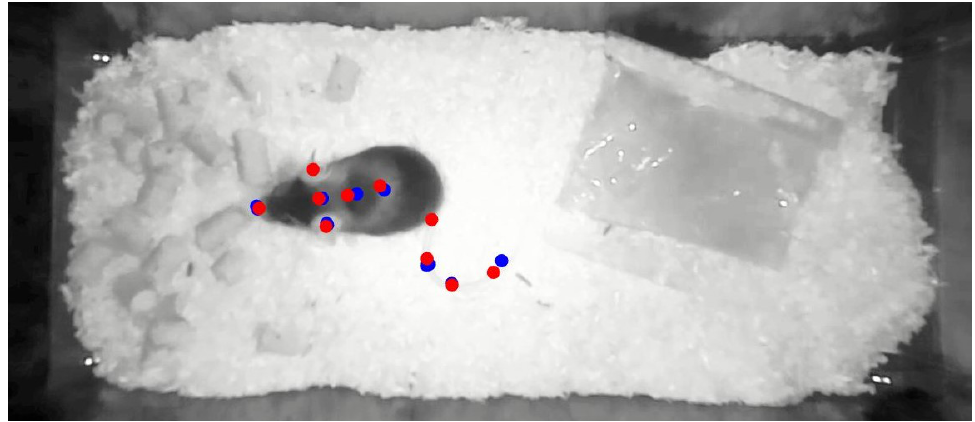
Figure 3. This figures shows a video frame of the camera reference system. The red dots illustrate manually set pose labels. The blue dots are estimates of a retrained deeplabcut